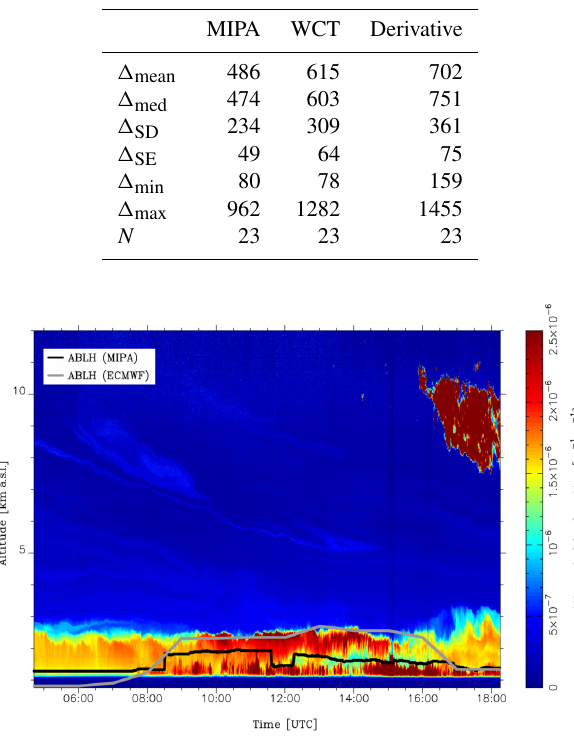
Figure 8. High-resolution time series of total attenuated backscat- ter at 1064nm measured over Potenza on 21 April 2010. Time res- olution is 60s; vertical resolution is 3.75m. The black and gray curve shows the ABLH as retrieved by MIPA algorithm and by us- ing ECMWF forecasts, respectively.